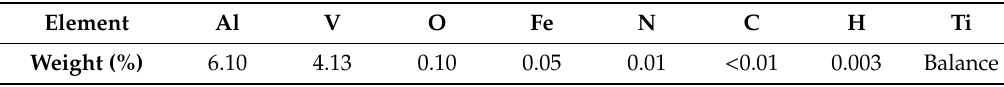
Table 1. Chemical composition of Ti-6Al-4V titanium alloy.